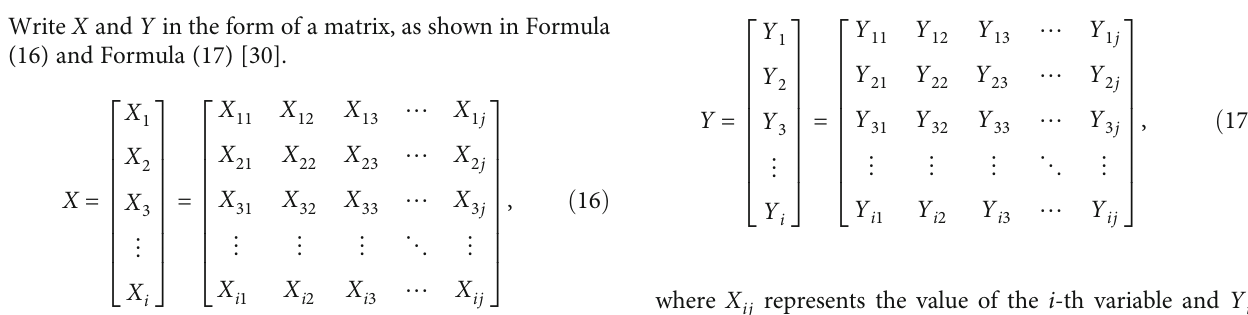
Figure 17: Model 15 stress distribution in numerical simulation. (a) t = 2 : 1 s . (b) t = 4 : 0s . (c) t = 5 : 0 s